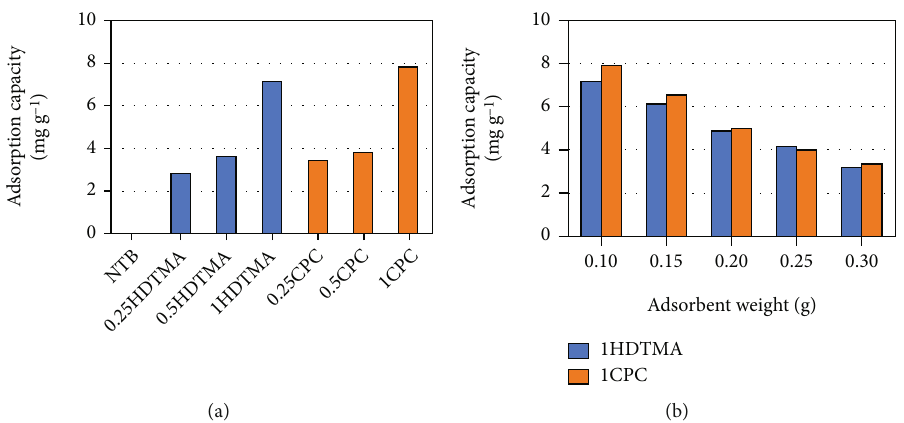
Figure 2: (a) Adsorption capacity of Cr(VI) depending on the surfactant types (CPC and HDTMA) and concentrations (0.25, 0.5, and 1CEC of NTB). (b) Adsorption capacity of Cr(VI) with di ff erent MTB weights (0.1 – 0.3g).